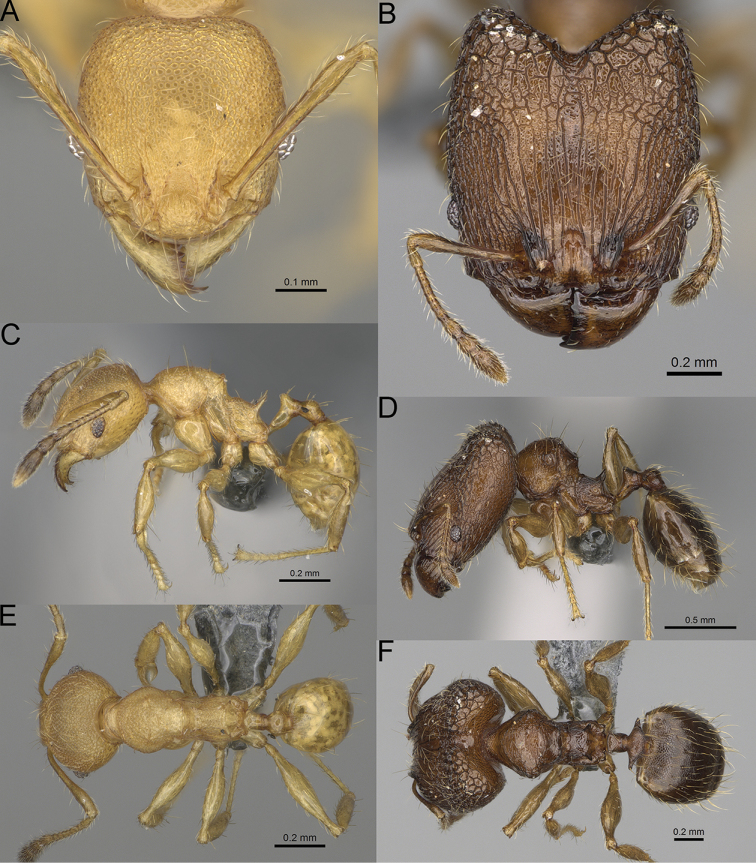
Pheidole
marieannae sp. nov., full-face view (A), profile (C), and dorsal view (E) of paratype minor worker (CASENT0808178) and full-face view (B), profile (D), and dorsal view (F) of holotype major worker (CASENT0923219).